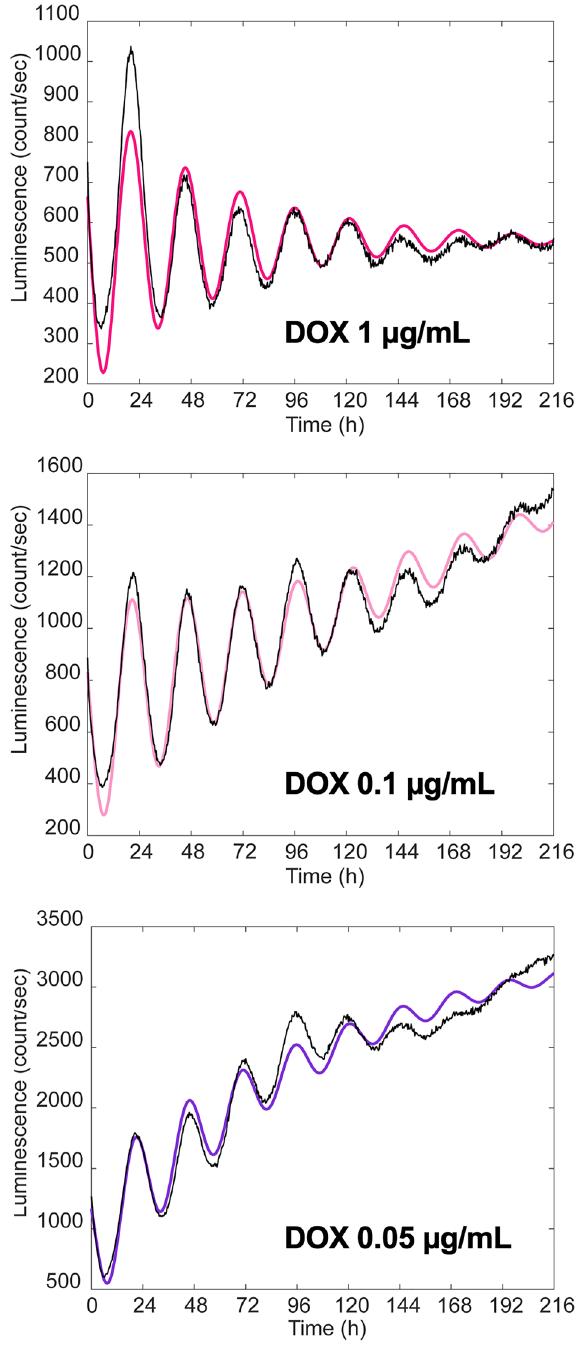
Figure 5. Transfer functions reproducing the behavior of P Bmal1 activity obtained by transient response analysis. Luminescence data of P Bmal1 activity in the presence of 0.05, 0.1 and 1 µg/mL doxycycline (DOX) shown in Fig. 1B were subjected to transient response analysis. Experimental values of luminescence intensity are shown in black and simulated data are shown in red for 1 µg/mL DOX (upper panel), pink for 0.1 µg/mL DOX (middle panel), and purple for 0.05 µg/mL DOX (bottom